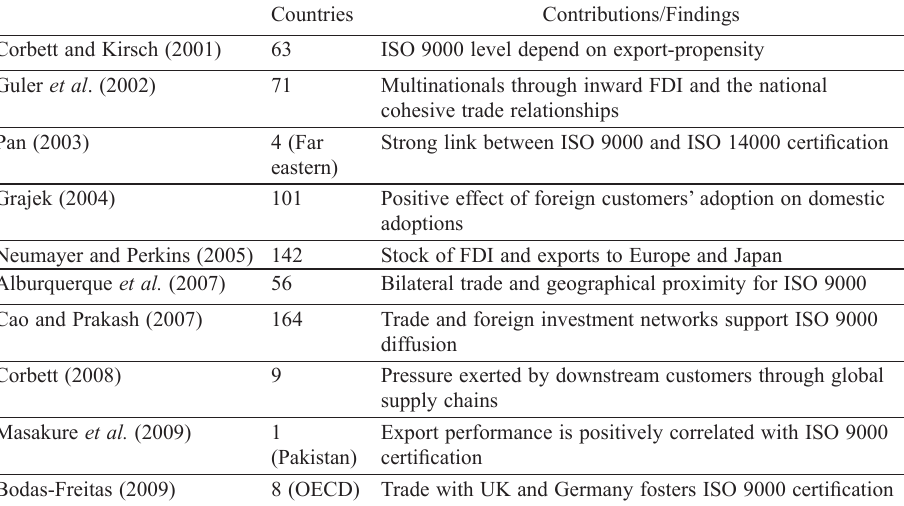
Table 1. Macro-level drivers of ISO 9000: an empirical literature review